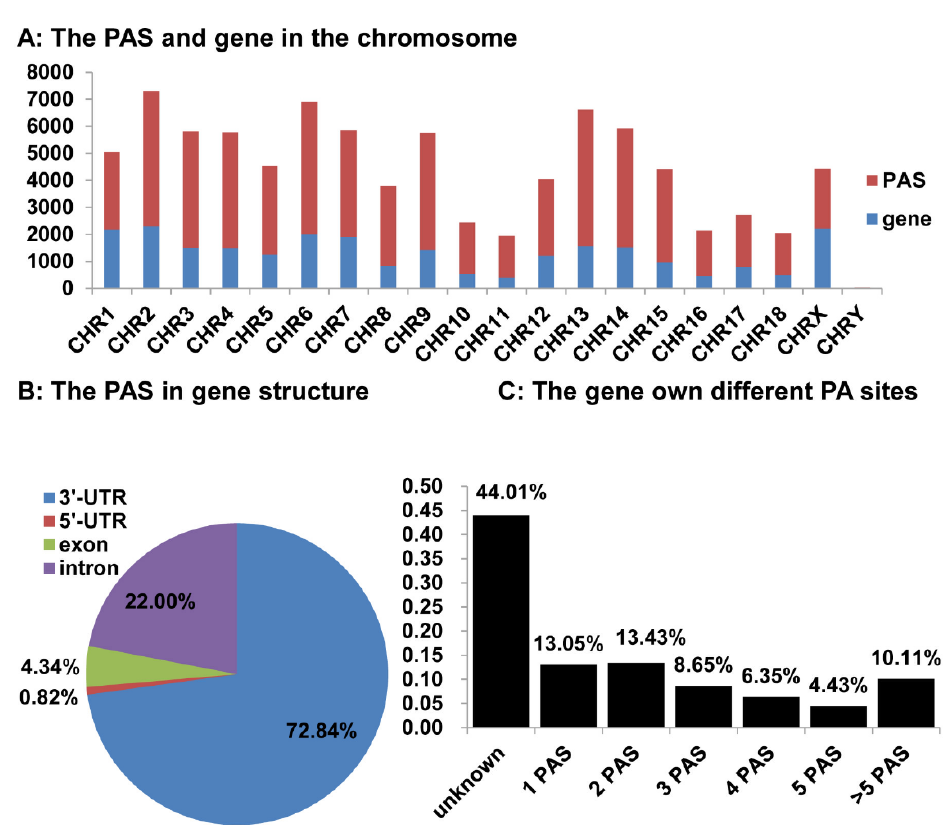
Figure 5. The alternative polyadenylation in Sus scrofa . ( A ) The number of PAS sites and their location was in the chromosome. We analyzed the PAS number distribution in the chromosome. The blue represents the gene number in the chromosome and the red represents the PAS number. ( B ) The PAS location in the gene structure. We analyzed the PAS occurrence frequency in the 5 (cid:48) UTR, exon, intron, and 3 (cid:48) UTR of genes. ( C ) The number of Sus scrofa genes with one or alternative poly(A) sites. We analyzed the number of PAS sequences per annotated gene, and grouped them as having 1, 2, 3, 4, 5, or over 5 PAS